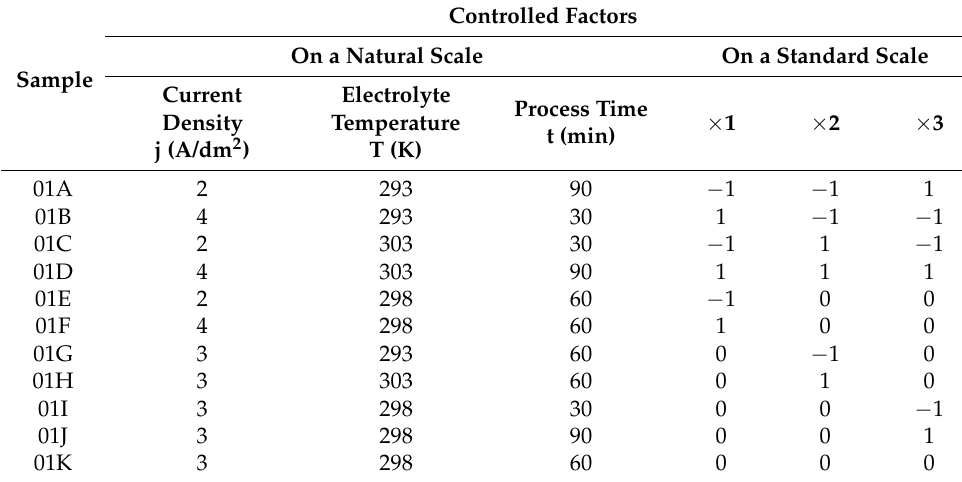
Table 1. Hartley’s plan for layers without thermo-chemical treatment.